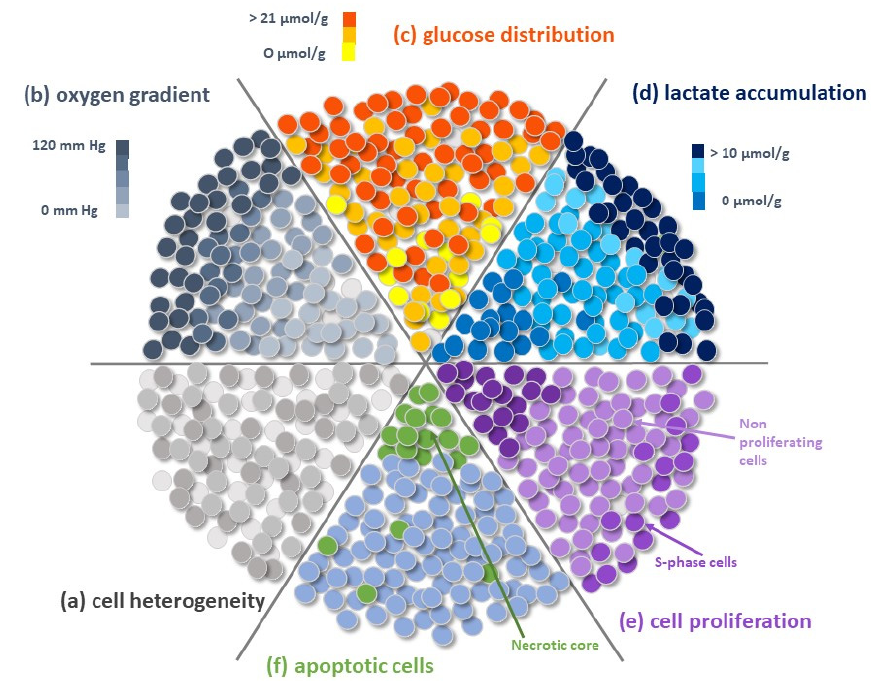
Figure 2. Schematic representation of a spheroid. ( a ) Spheroid heterogeneity, due to the presence of cells with different gene expression profiles and phenotypes, is represented by different grey spots. ( b , c ) The spheroid is composed of functionally differentiated layers resulting from the impaired distribution of oxygen (( b ), dark grey scale) and nutrients, mainly glucose (( c ), orange-yellow scale) that typically decrease from the periphery to the core of the spheroid. Consequently, the spheroid shows a well-defined spatial architecture characterized by the different distribution of ( d ) metabolites, i.e., lactate (blue-azure scale); ( e ) proliferating cells (violet scale) with the more dividing cells (S-phase cells) in the external layers and quiescent cells at the centre of the spheroid; ( f ) apoptotic cells (azure-green scale) that accumulate in the spheroid hypoxic core.